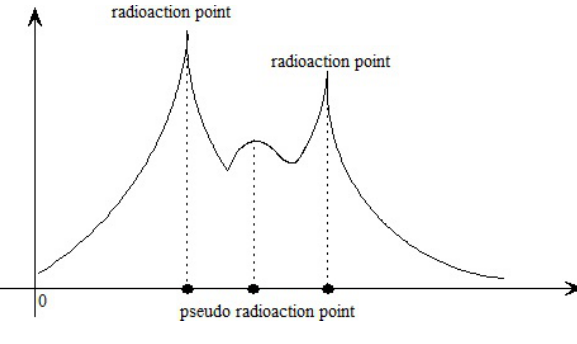
Fig. 5 A sketch of overlapping